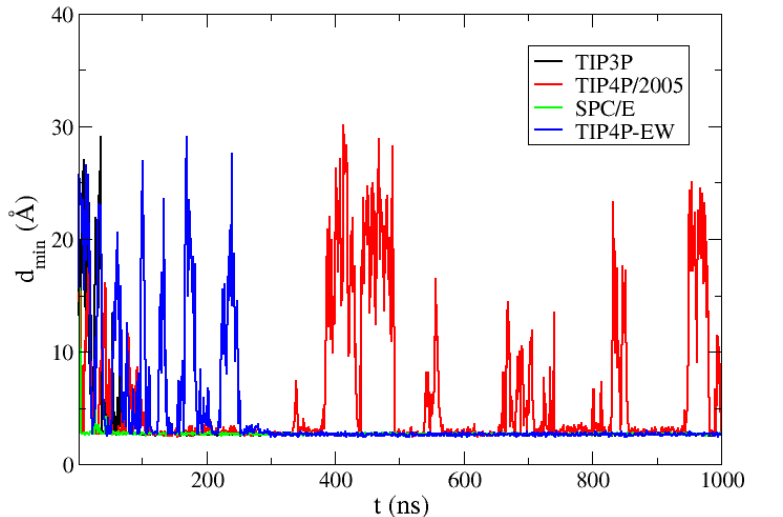
Figure 1. Minimum distance between two ubiquitin molecules in molecular dynamics simulations of a solution of ubiquitin at a concentration of 6.5 mM with four different water models: TIP3P, TIP4P/2005, SPC/E and